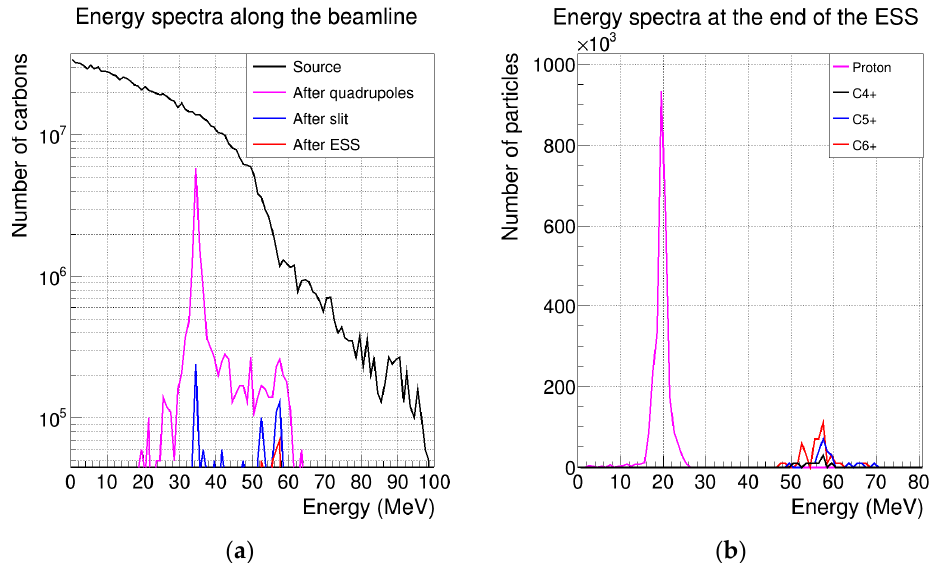
Figure 6. Energy spectra of carbon ions along ELIMED beamline: ( a ) Absolute energy spectra of C 6+ ions at different points along the ELIMED beamline; ( b ) Absolute energy spectra of protons (magenta line), C 4+ (black line), C 5+ (blue line) and C 6+ (red line) ions after the ESS. The spectra of C 1+ , C 2+, and C 3+ beams are not included because they are fully filtered before the end of the ESS.